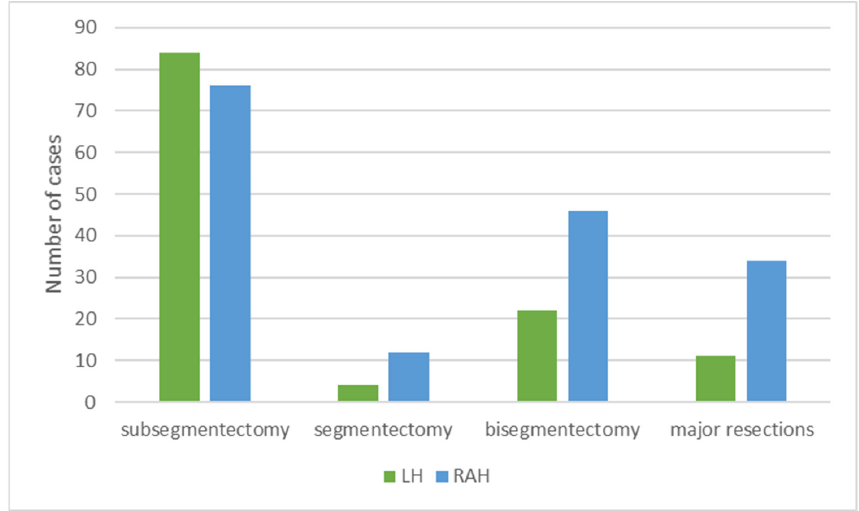
Figure 2. Distribution of surgeries performed.